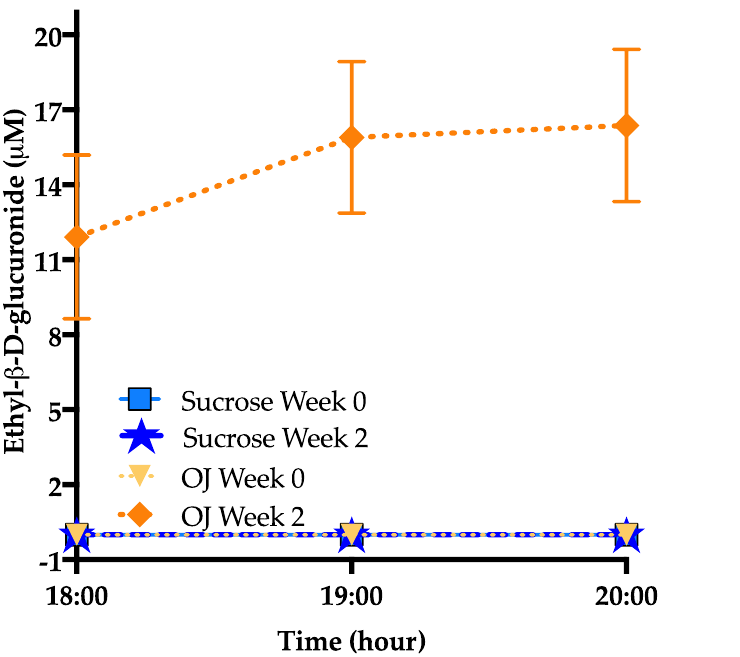
Figure 7. Baseline (week 0) and intervention (week 2) plasma ethyl- β -D-glucuronide before (18:00-h) and after (19:00-h and 20:00-h) consumption of an energy-balanced dinner. At baseline, dinner contained 55% Ereq as complex carbohydrate; at intervention, dinner contained 30% Ereq as complex carbohydrate and 25% as OJ or sucrose-SB.